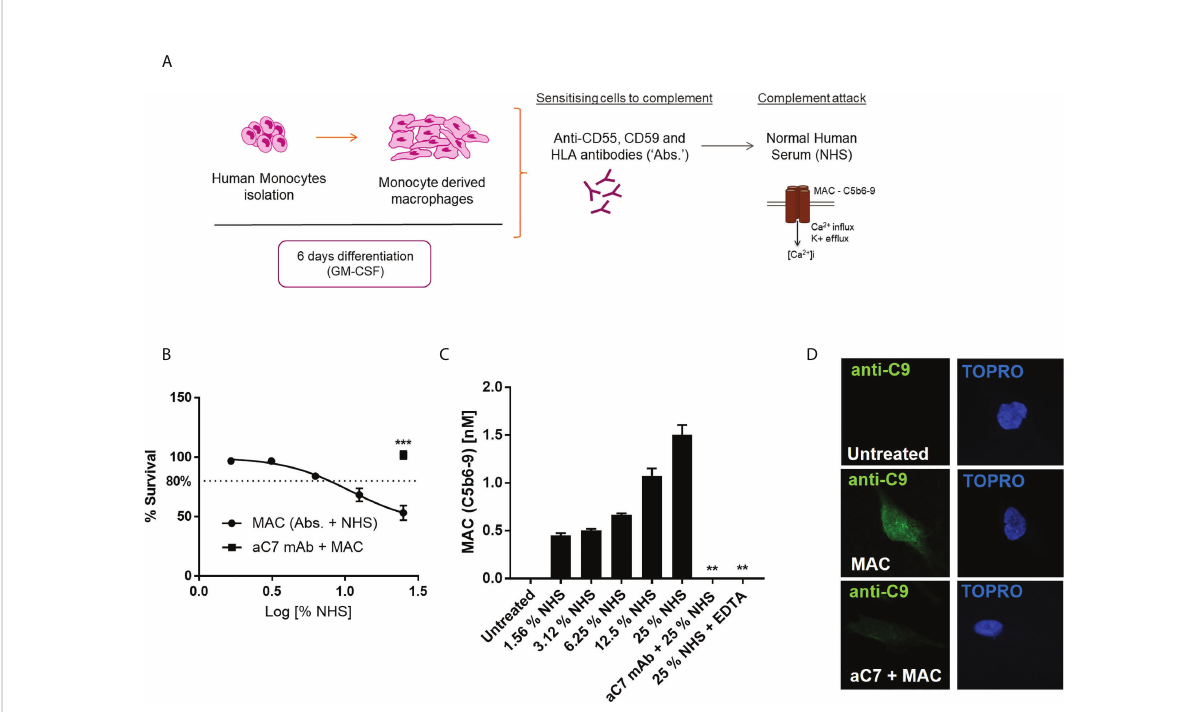
FIGURE 1 Establishment of suitable sublytic MAC deposition assay in hMDMs. (A) schematic of sublytic MAC deposition assay in hMDMs. (B – D) hMDMs treated with antibodies (anti-CD55, CD59, HLA) and increasing concentrations of NHS for 1 hour before viability measurement by CellTitreGlo (n=6; B), terminal complement component (TCC) MSD assay (n=3; C) or immunocytochemistry against C9 protein [n=3, representative image shown; (D) ]. Negative controls were performed by addition of anti-C7 (aC7) + MAC (B, D) and EDTA, which blocks complement activation (C only). Error bars represent mean ± S. E. M. ** = p<0.01, *** =